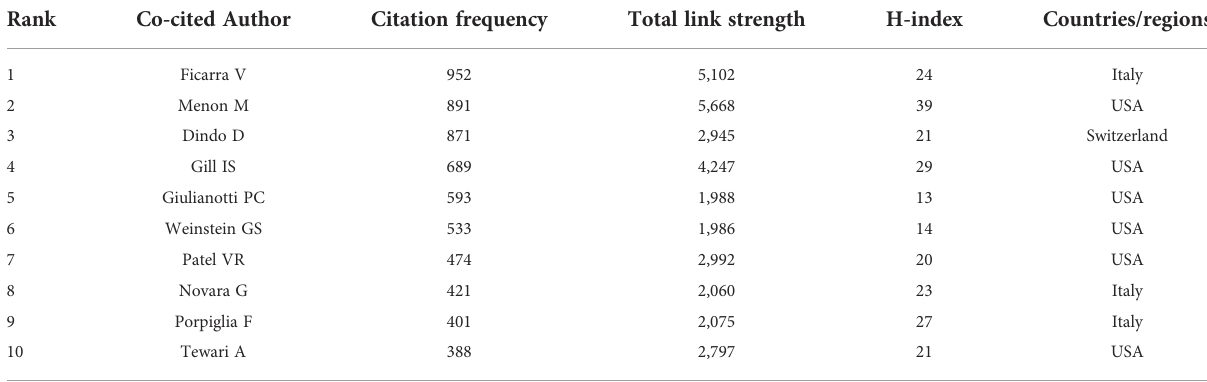
TABLE 6 The top 10 co-cited authors in terms of citation frequency related to robotic surgery in oncology.